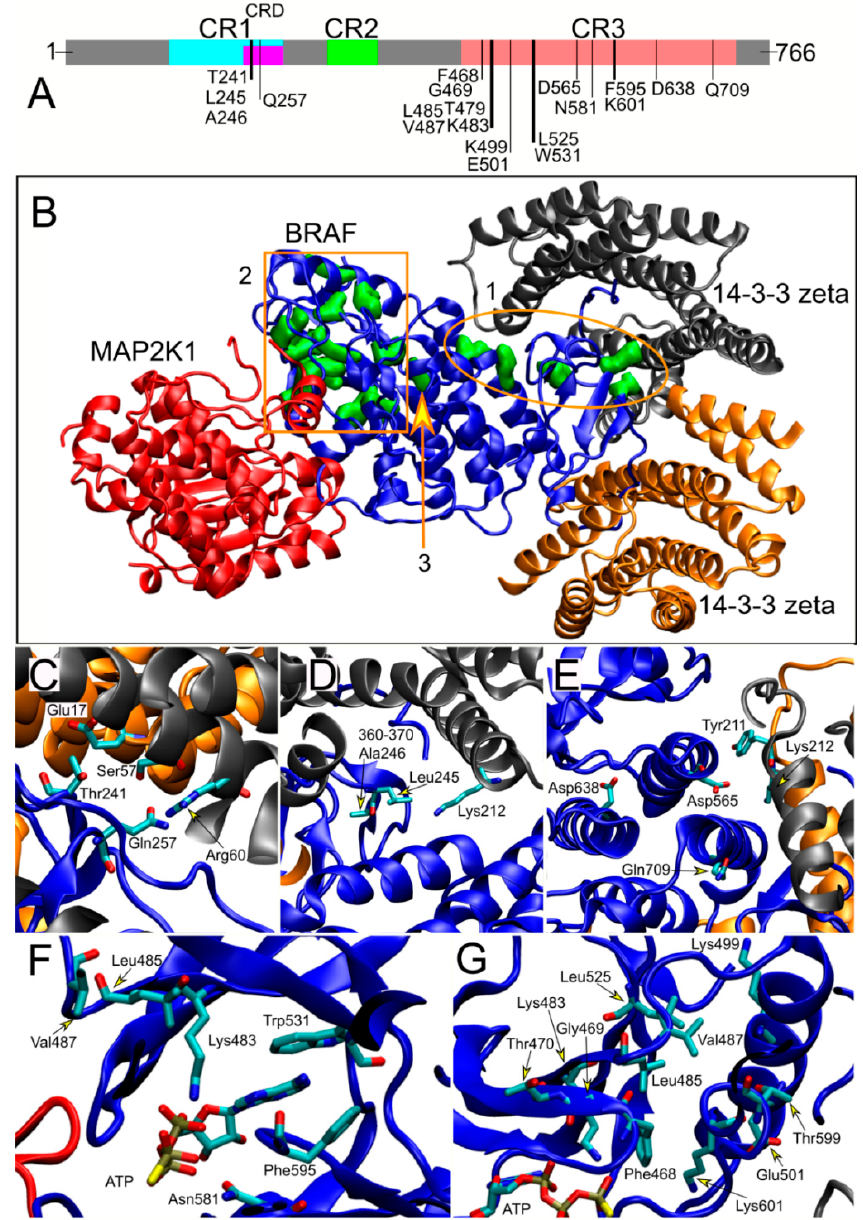
Figure 4. Domain organization of BRAF and location of residues mutated in CFCS. ( A ) Cartoon showing the domain organization of BRAF. The three conserved regions, CR1, CR2 and CR3, are highlighted in cyan, green and orange, respectively. The cysteine-rich domain (CRD, pink), located within CR1, contacts both subunits of the 14-3-3 zeta dimer in the inactive BRAF/MEK1/14-3-3 complex. Binding of the 14-3-3 dimer to phosphorylated Ser365 (CR2) and Ser729 (CR3) maintains BRAF in an autoinhibited state through an intramolecular interaction occurring between CR1 and the kinase domain CR3. In the active state, dephosphorylation of Ser365 results in an “open” con- formation of the kinase, which stabilizes its binding with activated RAS proteins. In this activated con formation, a 14-3-3 dimer rearranges to bridge pSer729 of two BRAF proteins, thus driving the formation of the active BRAF dimer (21). The autoinhibited state is stabilized by interaction of residues 598–602 in the activation segment (the so-called ‘inhibitory turn’) with hydrophobic resi- dues in the “GxGxxG” consensus sequence within the glycine-rich loop (residues 464–469) [21]. ( B ) Three-dimensional structure of the BRAF/MEK1/14-3-3 complex from cryo-electron micros- copy in its autoinhibited conformation (PDB 6nyb). BRAF, MEK1 and the two monomers of 14-3-3 zeta are highlighted in blue, red, gray and yellow, respectively. The positions of the affected resi- dues are highlighted in green. Two major mutation clusters are apparent: class I (1, ellipse), inclu- ding residues located in/close to the CRD contacting the 14-3-3 protein (i.e., Thr241, Leu245,